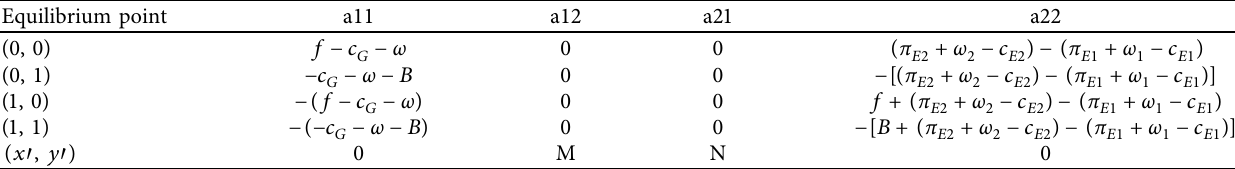
Table 5: Parameter value at the equilibrium